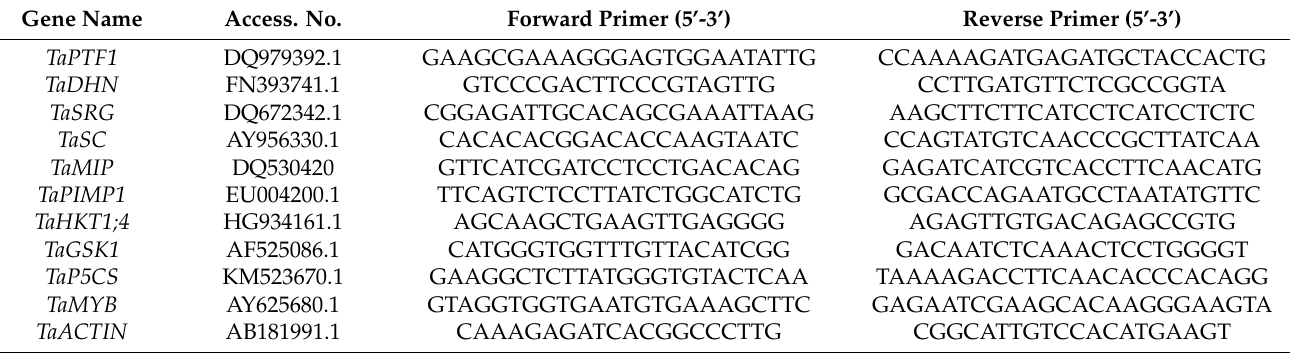
Table 2. Primer sequence of genes used in the